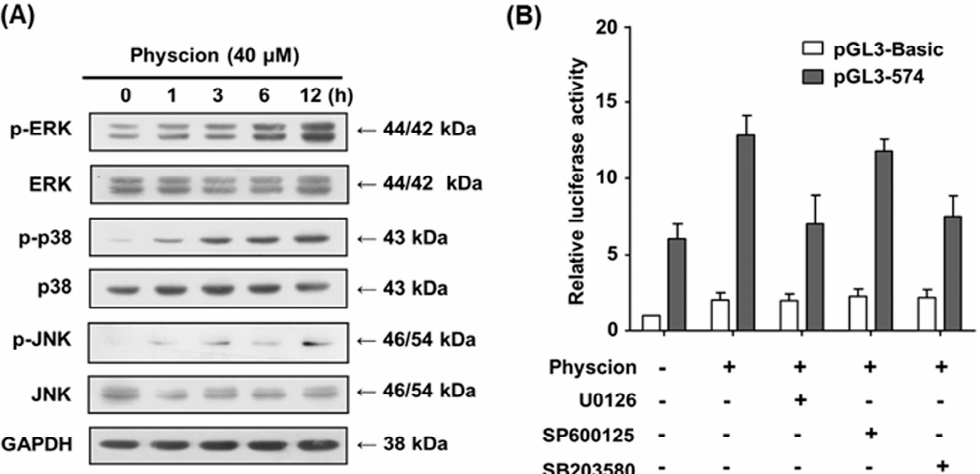
Figure 6. Physcion induced transcriptional activation of hST8Sia VI through ERK/p-38 MAPK signal pathways in SK-N-BE(2)-C cells. For representative immunoblot analysis of p-ERK, ERK, p-JNK, JNK, p-p38 and p38 protein expression levels, cells were treated with 40 μ M physcion for different lengths of time ( A ). pGL3-574 or pGL3-Basic was co-transfected into SK-N-BE(2)-C cells with pRL-TK. The transfected cells were incubated for 24 h in the presence of 40 μ M physcion with different inhibitors (10 μ M U0126, 10 μ M SP600125, and 20 μ M SB203580); The Renilla luciferase activity derived from pRL-TK was used to normalize all firefly luciferase activity. Data are the means ± SD of triplicate measurements and are representative of three independent experiments ( B ). +, treatment; -, untreatment.